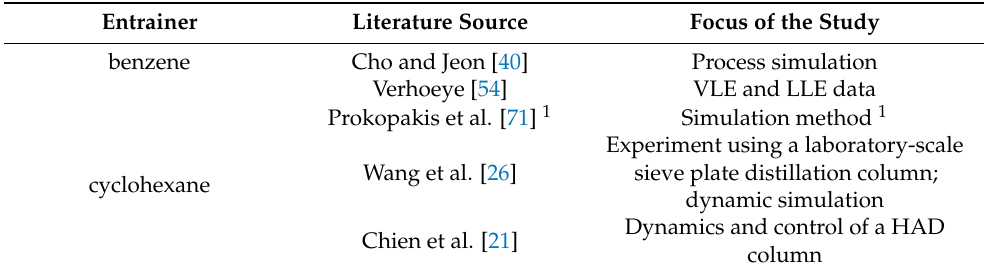
Table 2. List of entrainers considered in the literature for the dehydration of